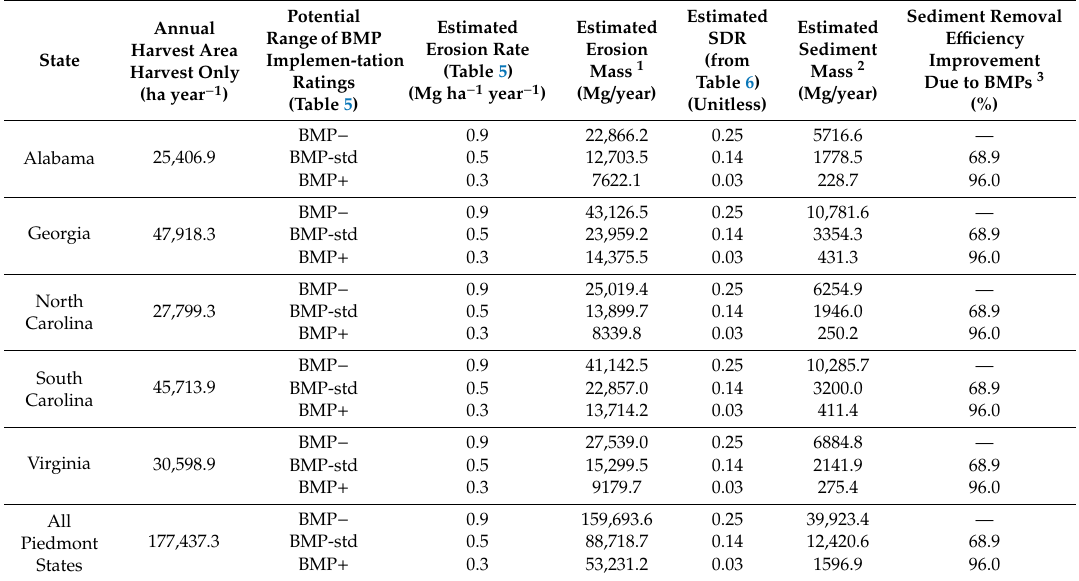
Table 7. Estimated erosion rates, erosion, masses, sediment delivery, and sediment removal e ffi ciencies due to BMP implementation levels by state harvest area (harvest